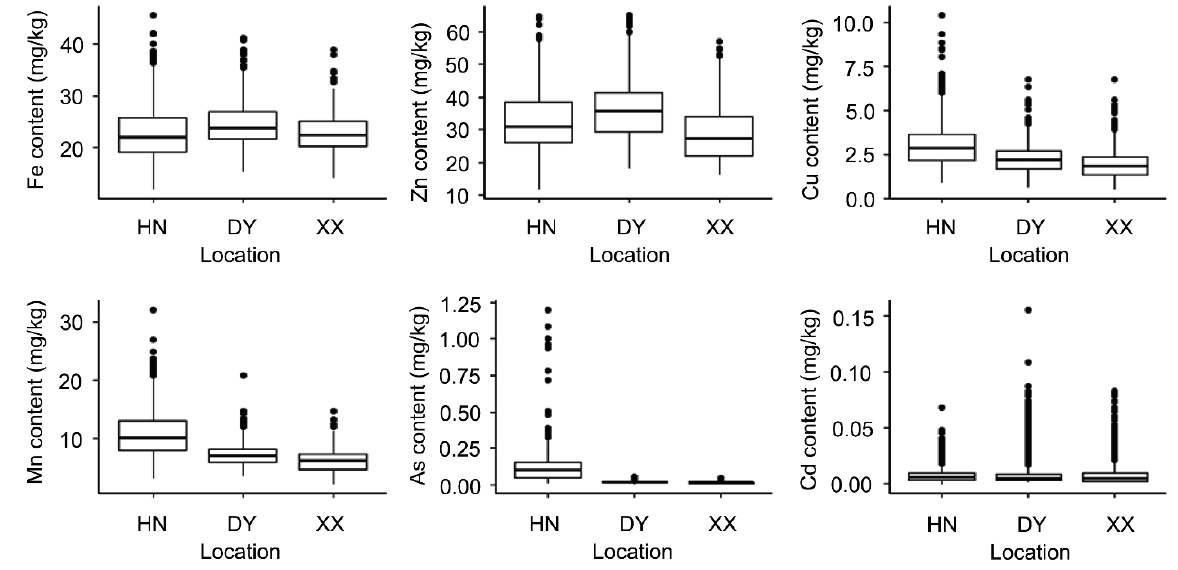
Figure 1. Contents of Fe, Zn, Cu, Mn, As and Cd in maize kernel in Hainan (HN), Dongyang (DY) and Xinxiang (XX).